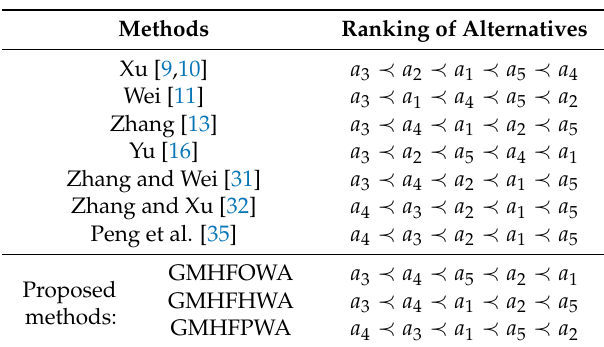
Table 4. Comparison of different